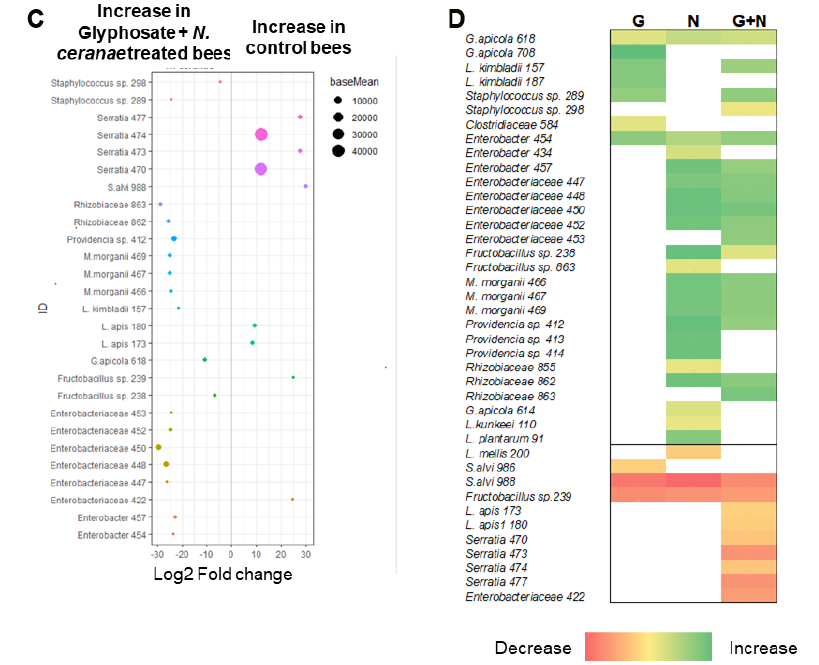
Figure 3. Impact of glyphosate, N. ceranae infection and both stress factors combined on the relative abundance of gut microbiota ASVs compared to control bees, analyzed using DESeq2. Ten honey bees (three/four bees per cage, from three cages) were individually analyzed per treatment. Only ASVs present in at least three individual samples and that show significant differences in relative abundance between groups are shown. ( A ) Comparison between honey bees subjected to chronic exposure to glyphosate (10 mg/L) for seven days and control bees; ( B ) Comparison between honey bees infected with N. ceranae (100,000 spores/bee at day 0) and control bees; ( C ) Comparison between honey bees subjected to both stress factors combined and control bees. In ( A – C ) a negative value of log2 fold changes means a decreased abundance in control bees (increased in Glyphosate/ N. ceranae or Glyphosate + N. ceranae groups) and a positive value means an increased abundance in control bees (decreased in treated groups). ( D ) Summary of the results of the pair-wise comparison between treated groups and control. Green indicates an increase in treated groups and red indicate a decrease in those groups.